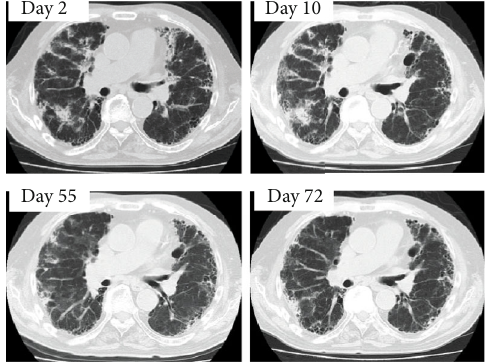
Figure 2: Changes in chest CT. Date is the number of days after starting AZA. Day 2: di ff use shading, and a regional in fi ltrative shadow in the right lower lobe is observed. Day 10: scattered nonregional increases in concentration are the same as before. No apparent exacerbation. Day 55: scattered irregular in fi ltrative shadows in both peripheral lungs and nondistrictal frosted concentrations are observed. Day 72: distinct in fi ltrative shadows scattered in the periphery of both lungs, with no signi fi cant